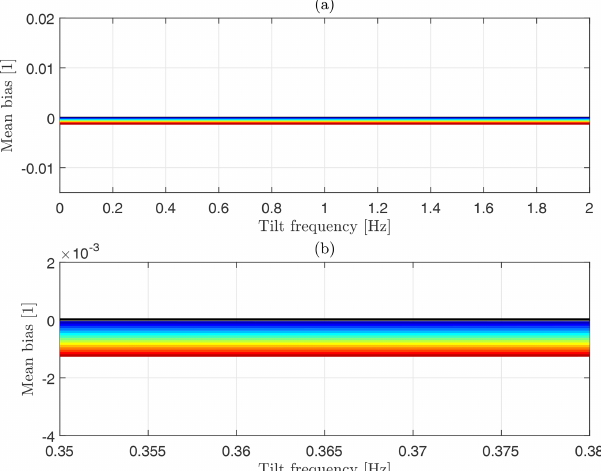
Figure 7. (a) Mean bias caused by pitch motion as function of os- cillation frequency f p for amplitude of motion A = 10 ◦ without (black) and with (color) consideration of wind shear characterized by shear coefficients α = 0 . 01 (blue) to 0.15 (red). Results from simulation (solid) and analytic solution (dashed). (b) Enlarged vi- sualization of plot above for 0 . 35 ≤ f p ≤ 0 . 38.